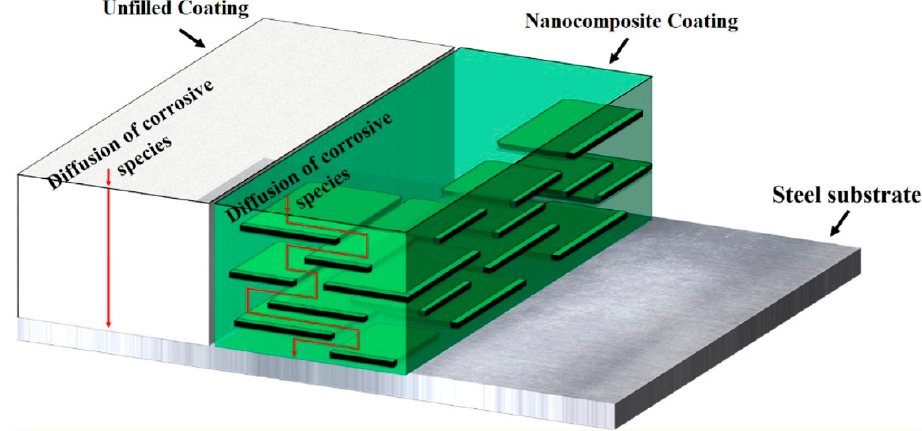
Figure 1. The labyrinth effect of 2D nanolayers on the barrier properties of an organic coating [32].